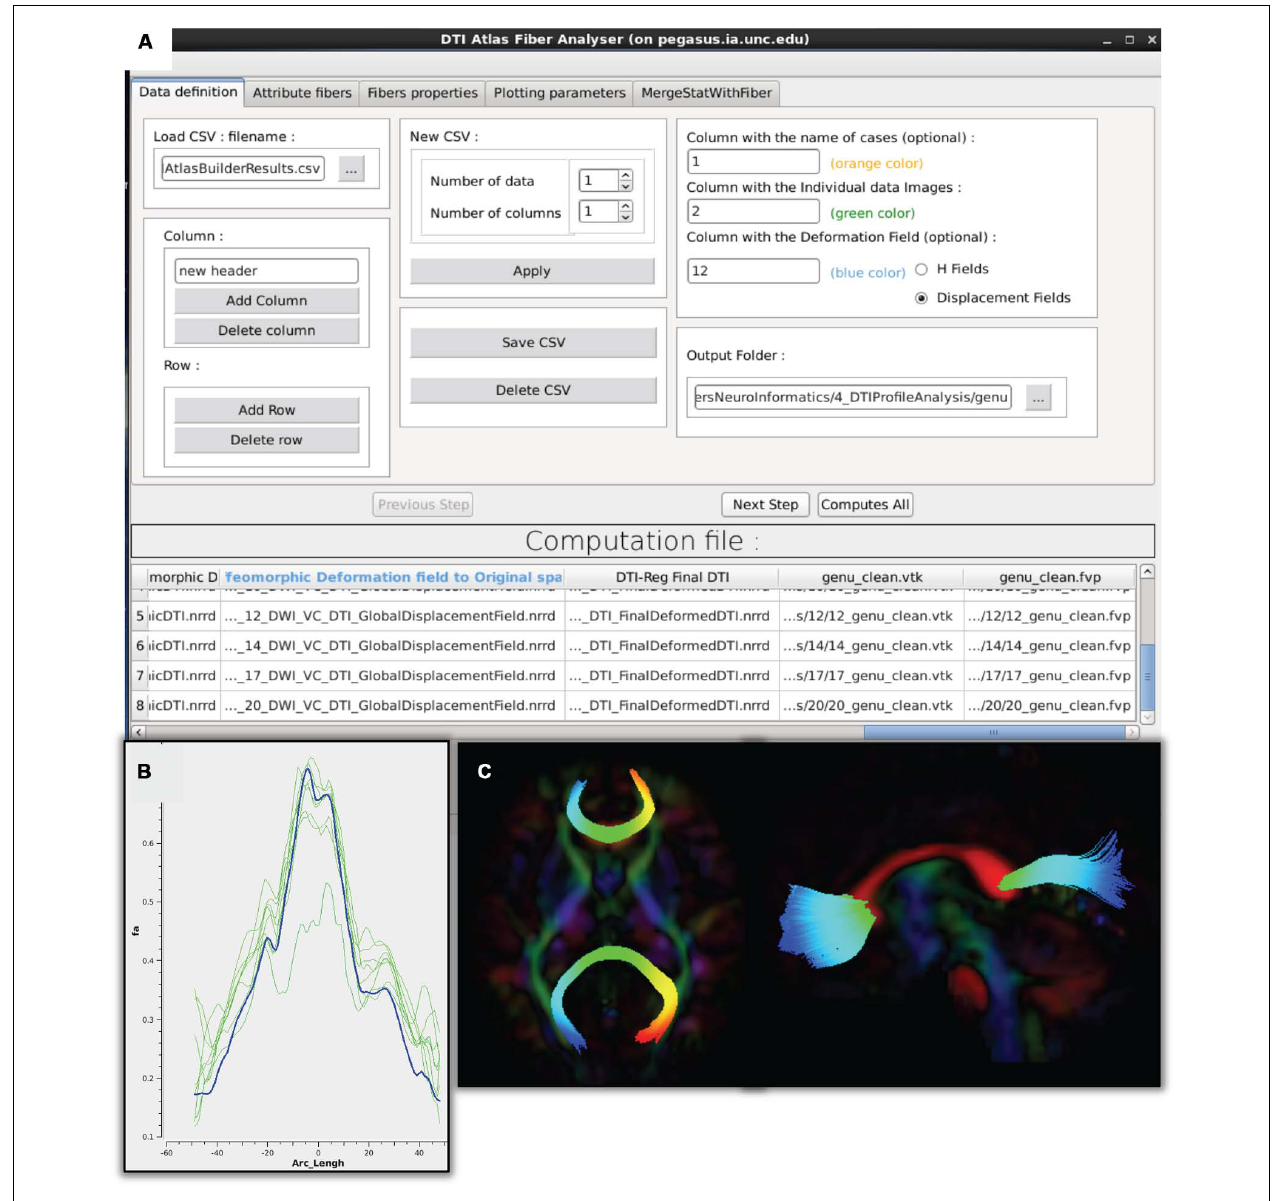
registrations.The FA profiles of the subjects (pictured here) should be similarly shaped to the atlas. (C) Visualization of the parameterized genu and splenium fibers in the axial and sagittal views. Fibers that have been correctly parameterized with DTIAtlasFIberAnalyzer via the origin plane will be colored by FiberLocationIndex (arclength) from red to blue. Red indicates low arclength and blue high arclengths.The corresponding profile plots of these genu and splenium fibers would run from the right to the left